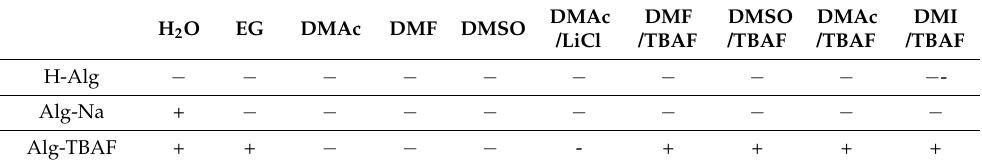
Table 1. Solubility of alginates in various solvents (c = 15 mg/mL).